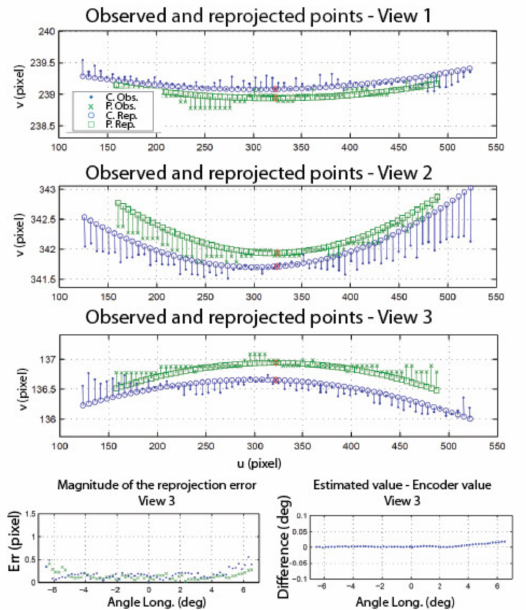
Figure 26. Observed position of the circle and speckle pattern and reprojected circle and speckle pattern based on the estimates for R MC and T MC . The central sweep for the three views is shown. The magnitude of the reprojection error for the circle and pattern is under 0.5 pixel and the error in angle measurement is very close to 0 ◦ . For display purposes, the small rotation around the optical axis of the camera (component E MCz of E MC in Figure 25) has been